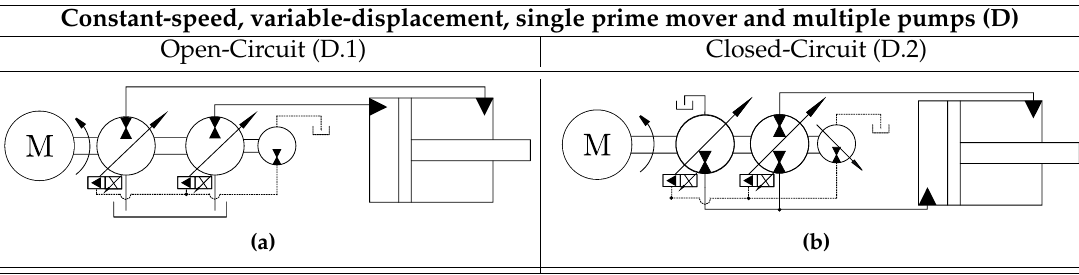
Figure 8. Overview of class D architectures (simplified schematics). ( a ) Open-circuit configuration; ( b ) Closed-circuit